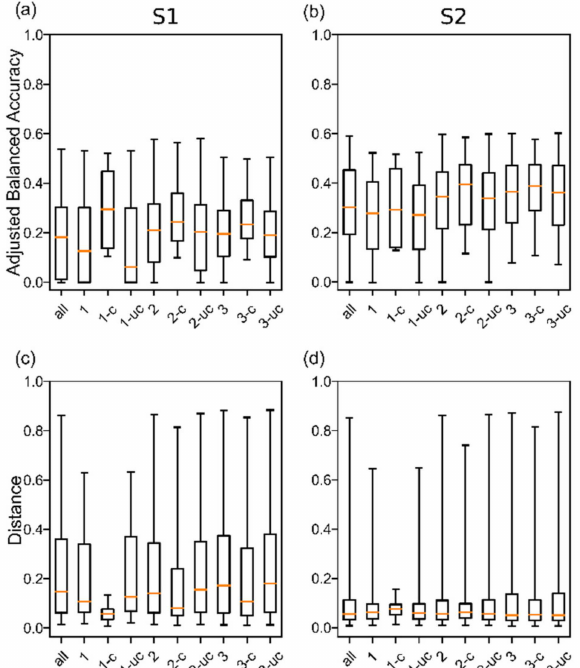
Figure 9. Boxplot distributions of the ABAS ( a ) and distance ( c ) metrics for the 3D S1 configuration, and ( b , d ) for the 3D S2 configuration. The cases are identified by the number of defects and by defect position with “c” referring to centered cases and “uc” to uncentered cases. The distances are normalized